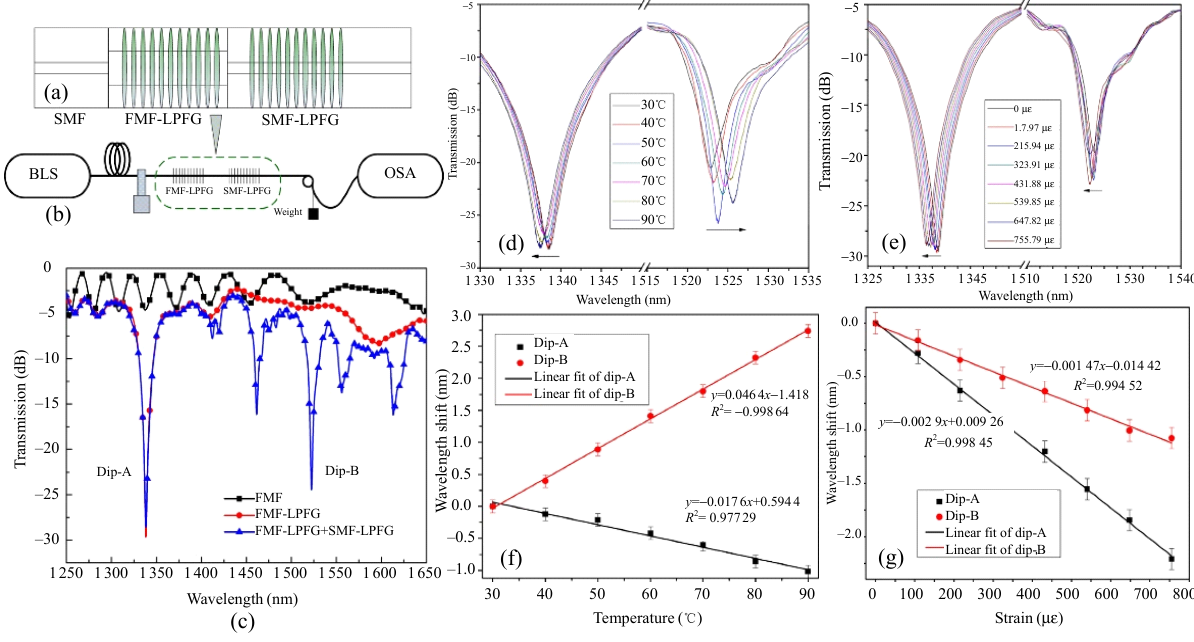
Fig. 7 Schematic diagrams and experimental setup of the dual-LPFG sensor, and its temperature and strain responses